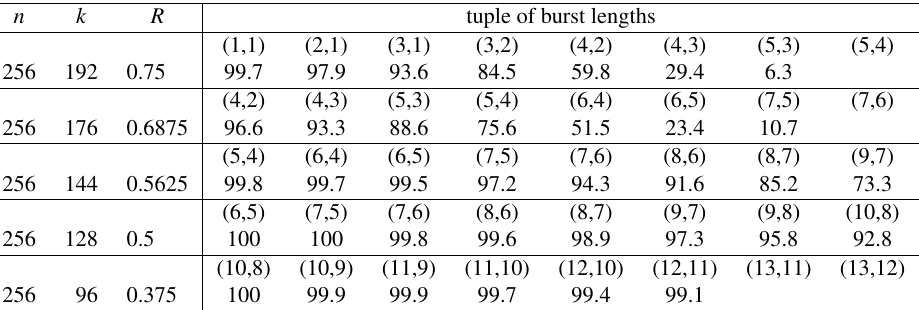
Table 2. Correcting capabilities (%) measured by the ratio of frames which are able to be corrected n